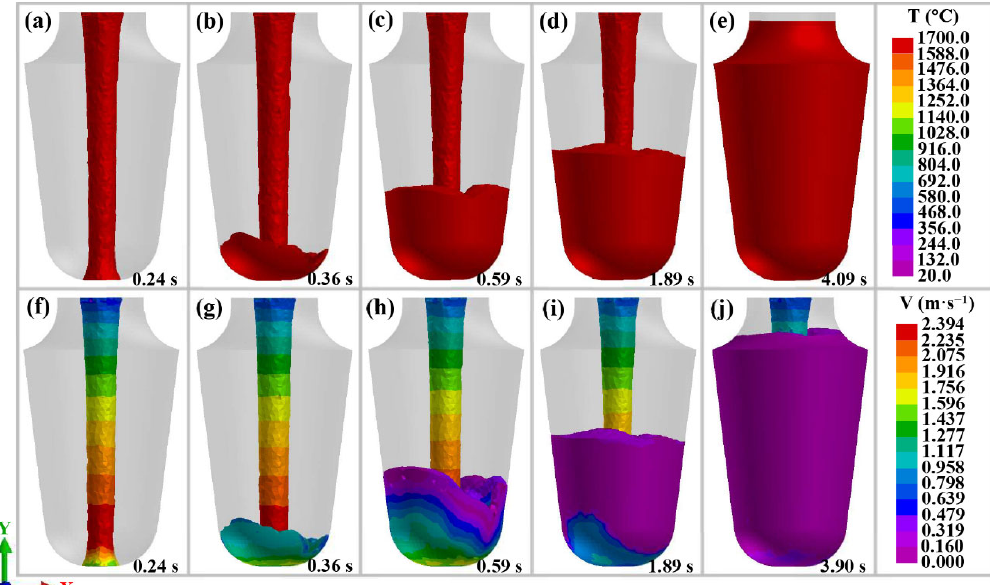
Figure 2. Filling process ( a – e ) and fluid velocity ( f – j ) of Ti ‐ 6Al ‐ 4V alloy in mold